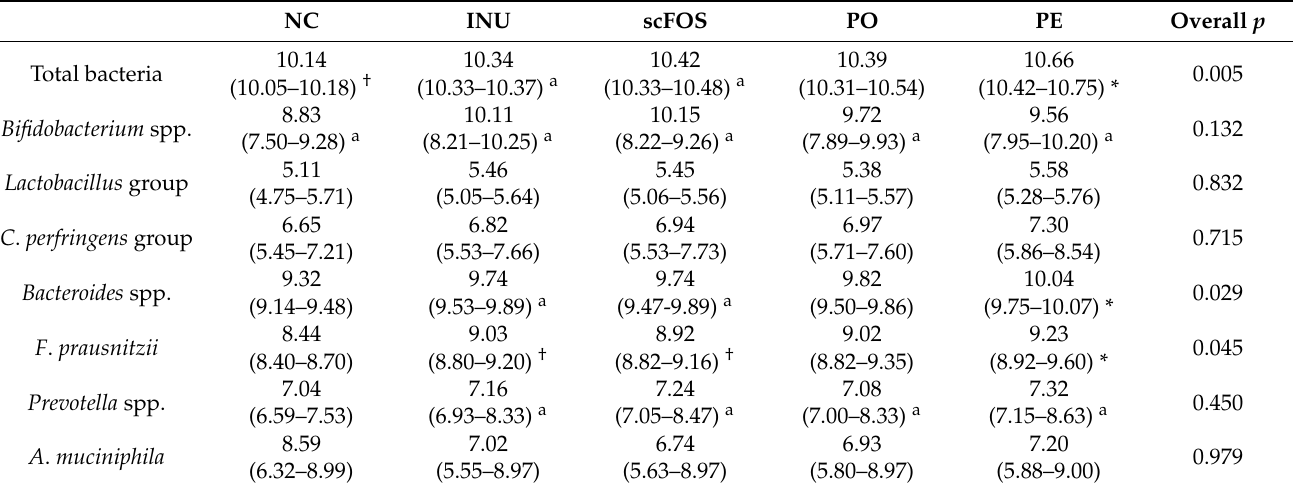
Table 5. Fecal microbial quantification after 24 h of fermentation in ASD